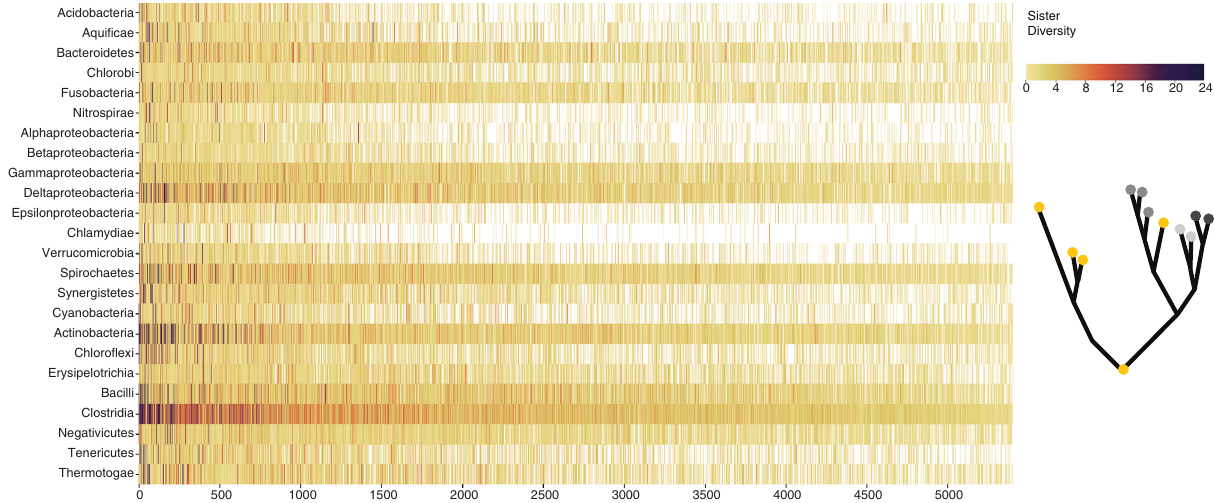
Fig. 3 Sister diversity analysis of 5402 phylogenetic trees reveals Clostridia is the most ancestral group. Sister diversity (maximum number of different groups in the sister clade) for each group (rows) for 5402 trees with at least six groups (columns). An illustrative tree portrays the question asked in the analyses, where the yellow group is the one with the highest sister diversity score and therefore inferred as most